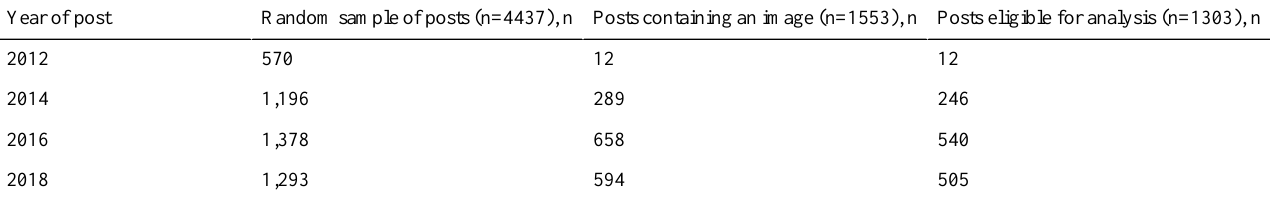
Table 1. Number of posts selected for